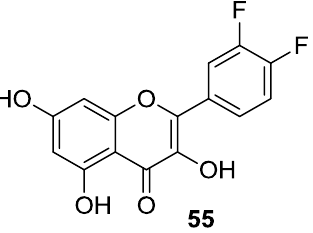
Figure 7. Structure of quercetin derivative 55 obtained via replacement of catecholic hydroxyl groups.